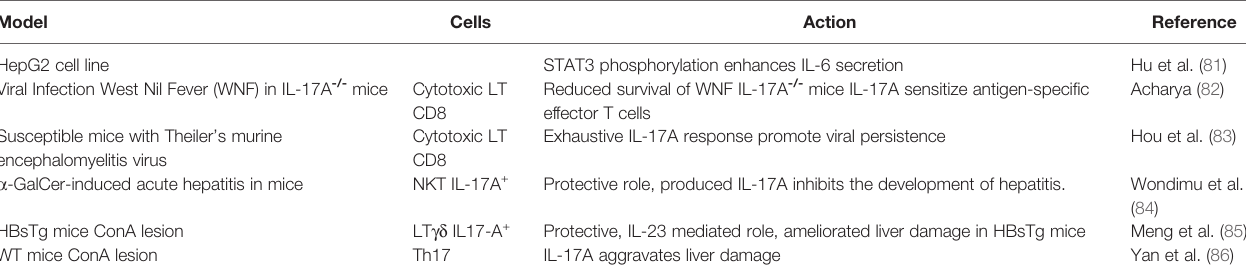
TABLE 1 | IL-17A in acute liver